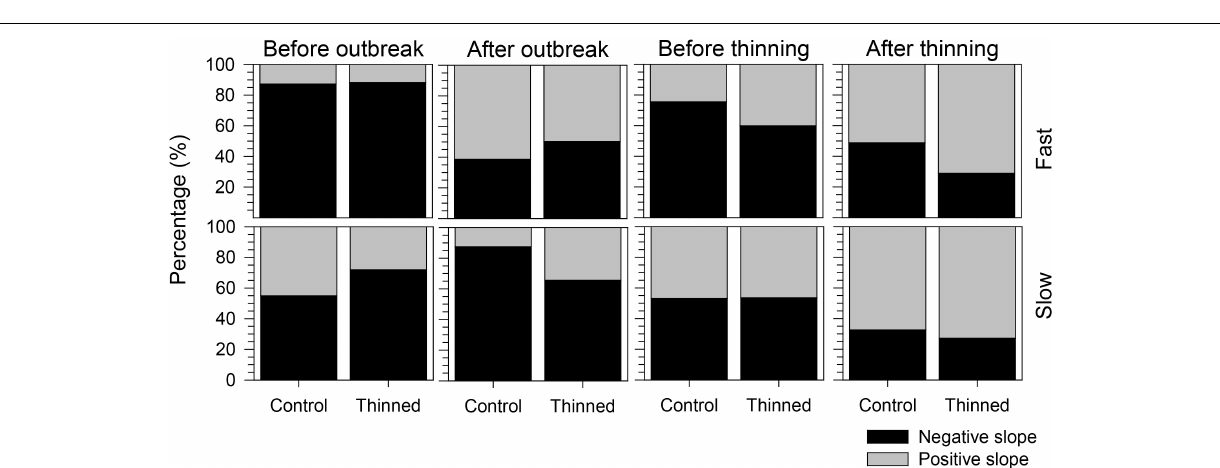
FIGURE 6 | Proportion of positive and negative slopes of the regressions calculated during the 4 years before and after spruce budworm outbreak and